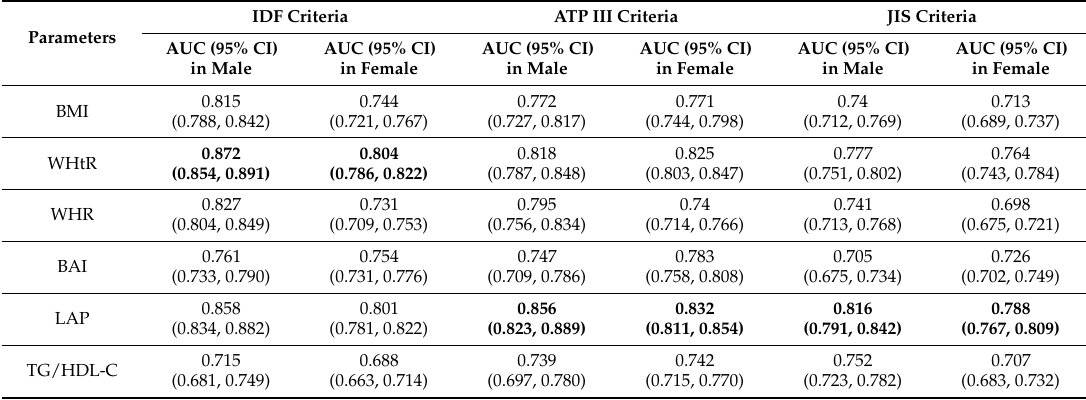
Table 2. AUC of each variable for the screening of MetS in Kazakhs.